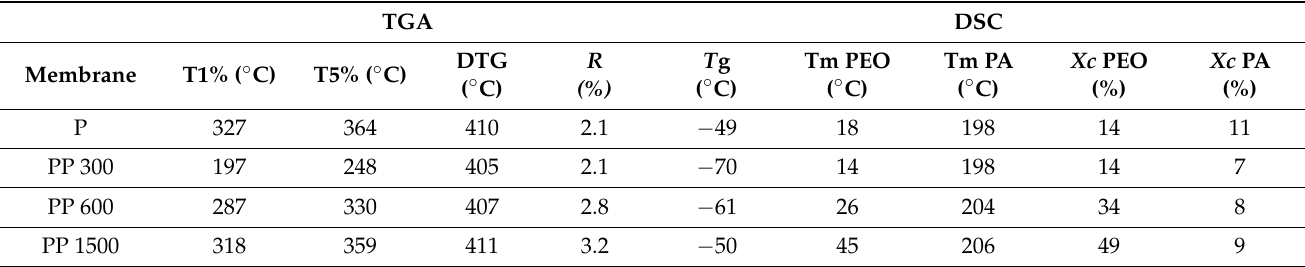
Table 2. Thermal properties of neat Pebax and Pebax/PEG